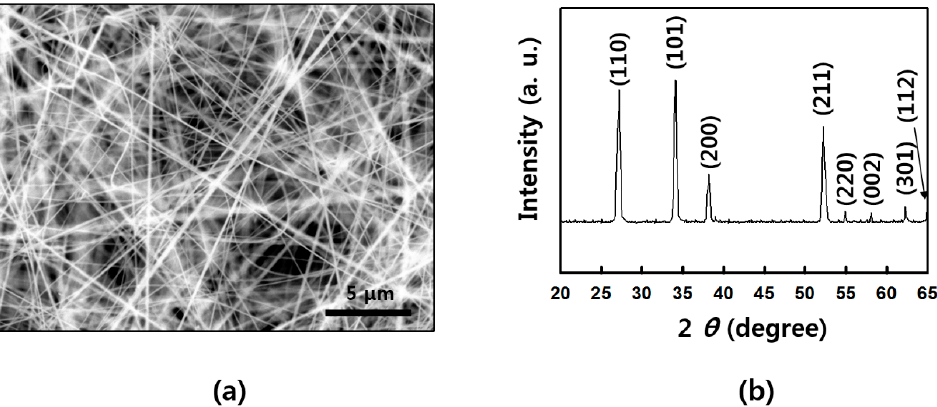
Figure A2. Structure of as-grown SnO 2 NWs: ( a ) scanning electron microscope (SEM) image of SnO 2 NWs; ( b ) X-ray diffraction (XRD) data of a rutile SnO 2 NWs. Materials 2019 , 12 , x FOR PEER REVIEW